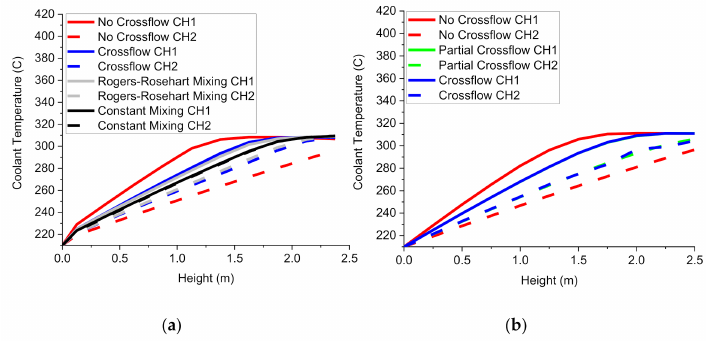
Figure A8. ( a ) CTF coolant-temperature axial distributions; ( b ) FLOCAL coolant-temperature ax- ial